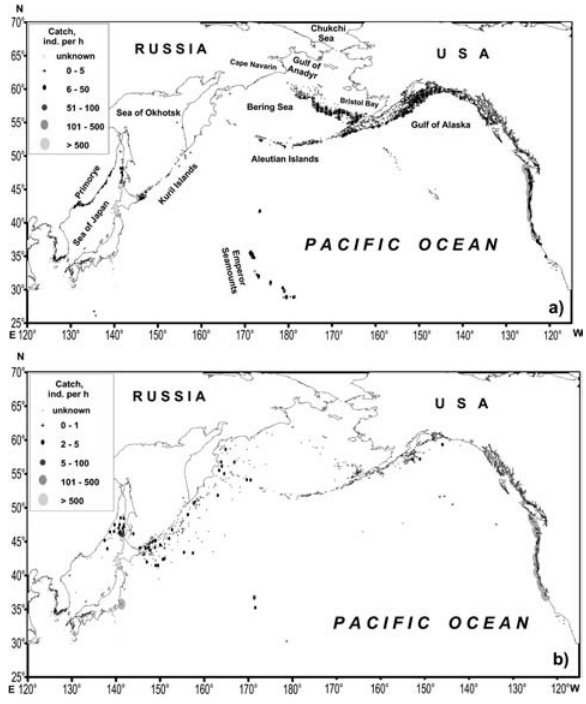
Fig . 1. – Distribution and relative abundance of Squalus suckleyi in the North Pacific based on bottom trawl (a) and pelagic trawl (b) catch data